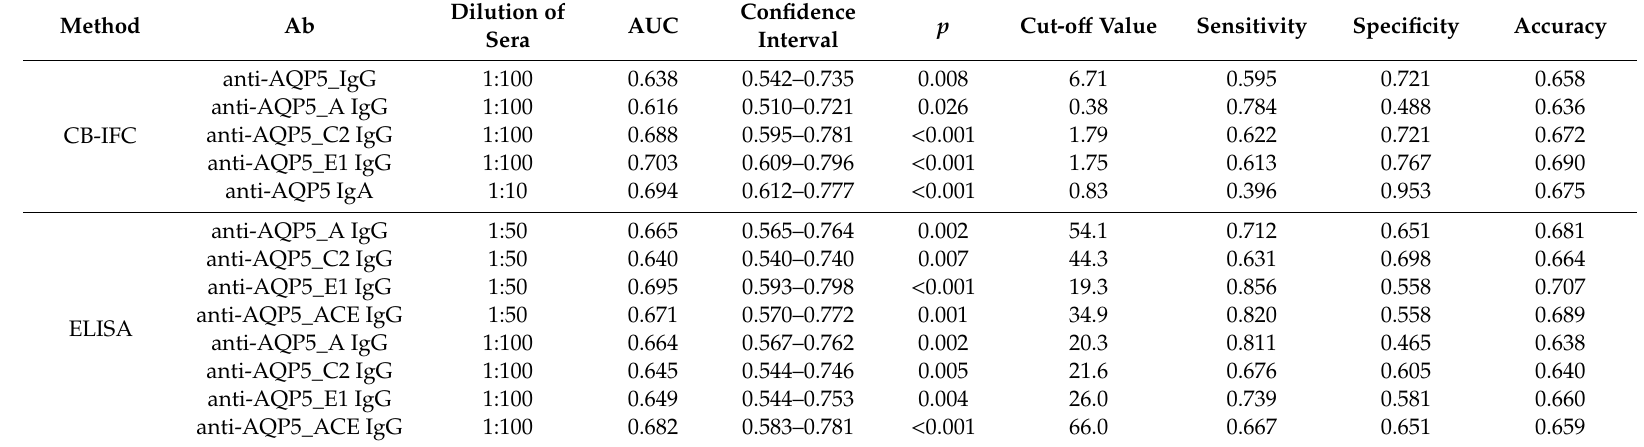
Table 2. Diagnostic performance of anti-AQP5 autoantibodies in 154 Sjögren’s International Collaborative Clinical Alliance (SICCA) registry samples by receiver operating characteristic (ROC)